Question: Which kind of chart has been used to present this data?
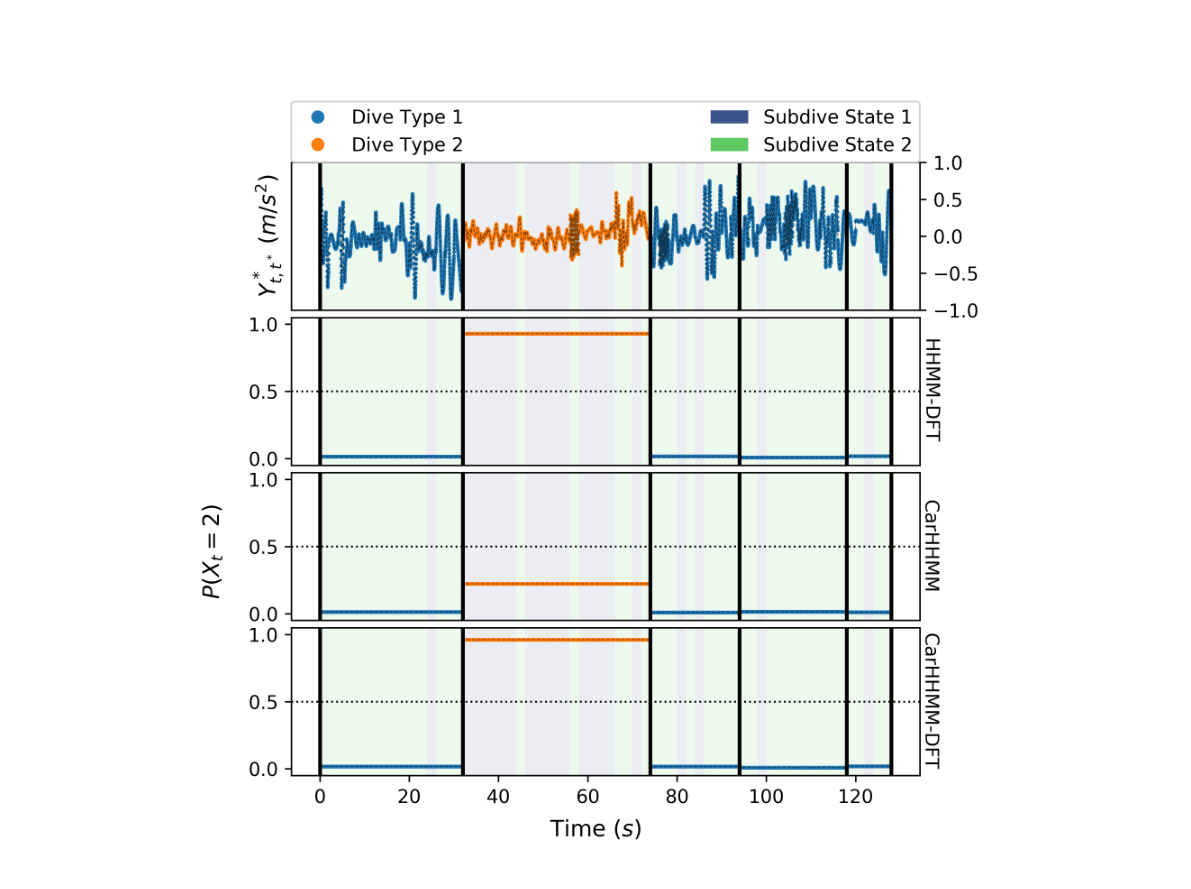
Answer: line